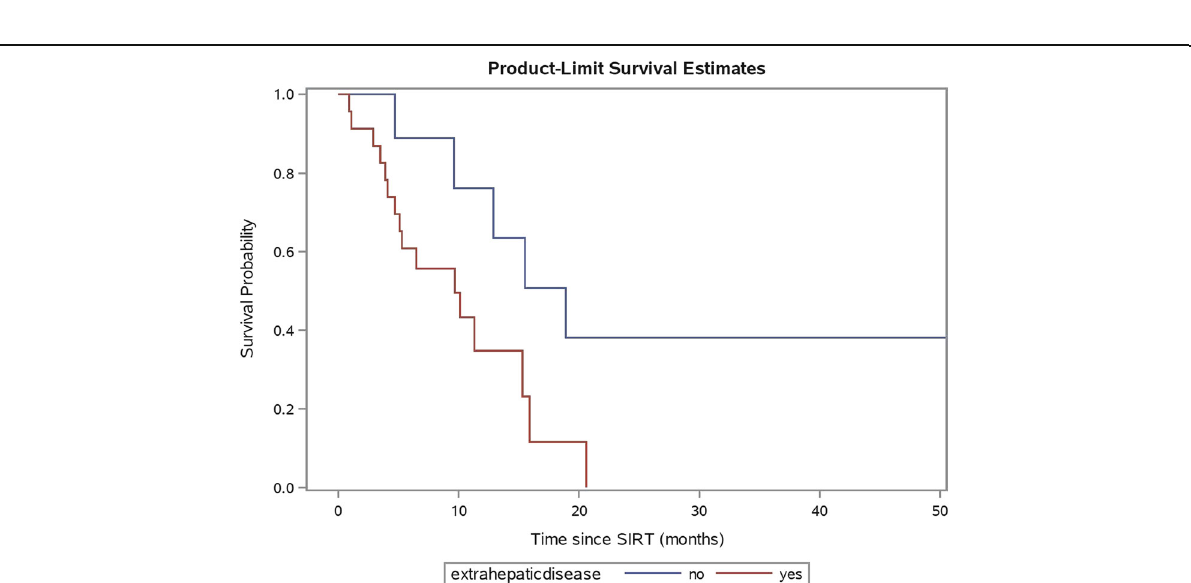
Fig. 7 Kaplan-Meier plot of patient survival by presence or absence of extrahepatic disease on FDG PET/CT prior to radioembolisation. Patients with presence of extrahepatic disease had lower overall survival ( p = 0.03 by log-rank test)